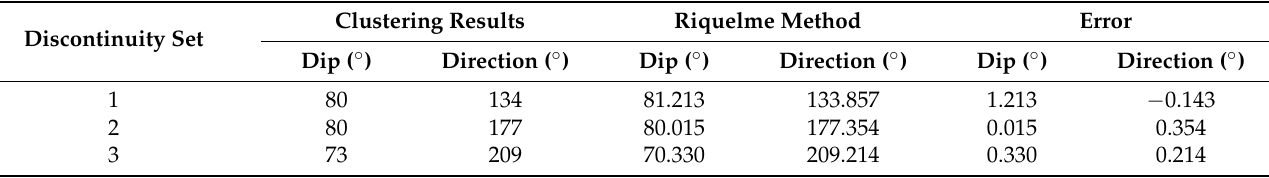
Table 3. Comparison of clustering results between the proposed method and Riquelme’s method.